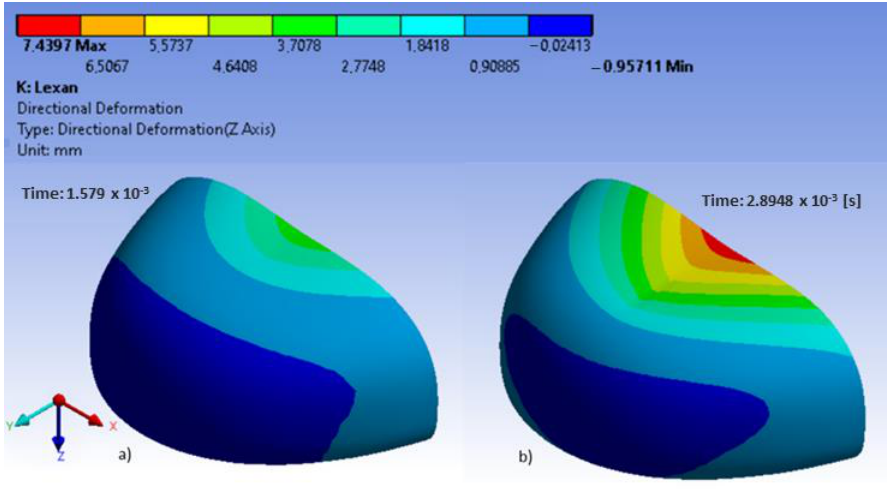
Figure 5. Deformation (approx. 7.5 mm) of polycarbonate toecaps in two time steps: ( a , b ) external side.